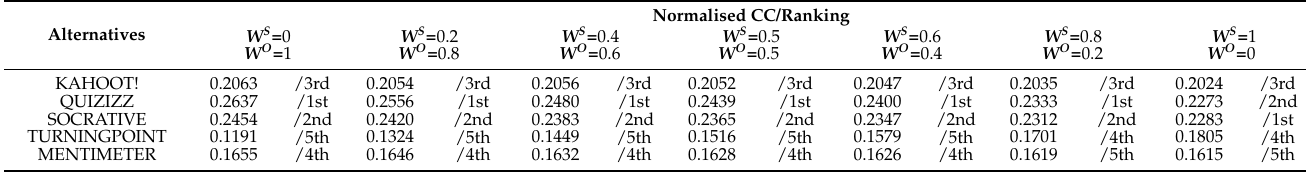
Table 18. Sensitivity analysis with objective weights from fuzzy Shannon entropy.